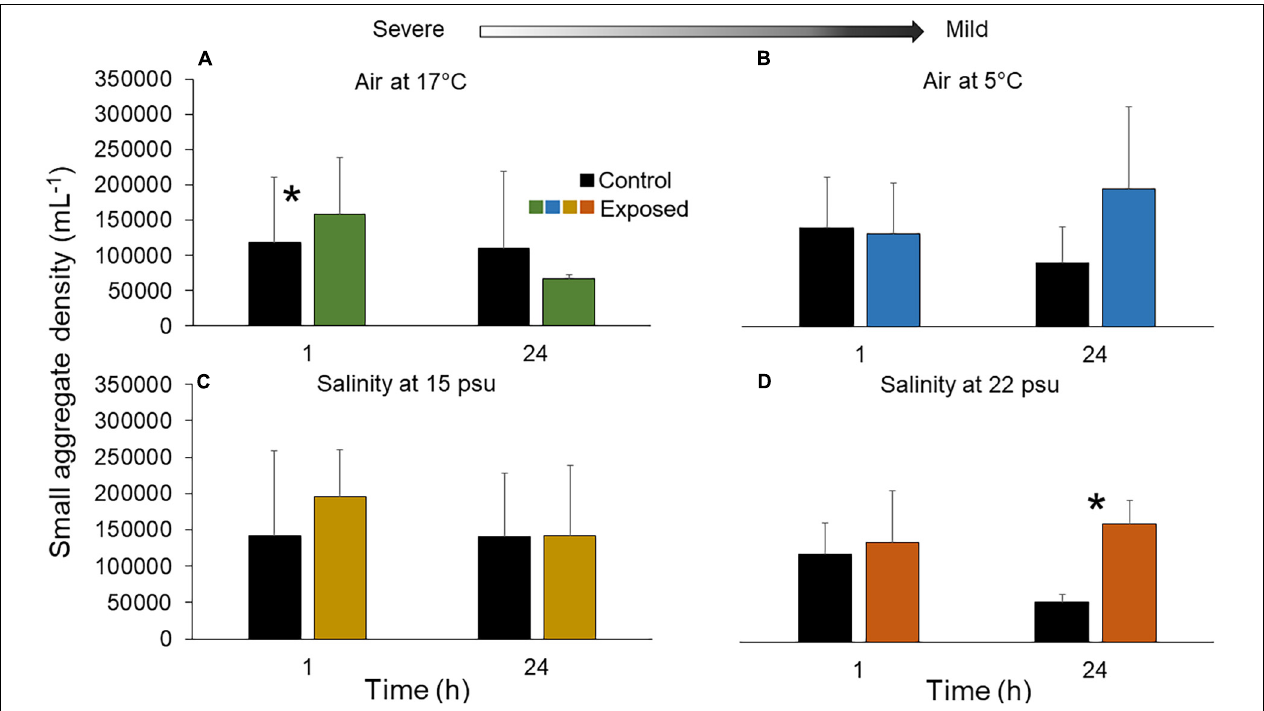
FIGURE 4 | Density of small aggregates in fluid of the Polian vesicle (mean ± SD, n = 5–10) after exposure of sea cucumbers to (A) 17 ◦ C air (B) 5 ◦ C air (C) 15 psu salinity and (D) 22 psu salinity. The asterisk (*) indicates significant differences between control and exposed individuals ( p < 0.05) at each time point. There was no statistical difference between treatment groups at different time points ( p > 0.05). Arrow indicates severe and mild stressors relative to the control. Measurements were made immediately after the exposure (1 h) and after a 23 h recovery period (total of 24 h). Main statistical results are shown in Supplementary Table 2